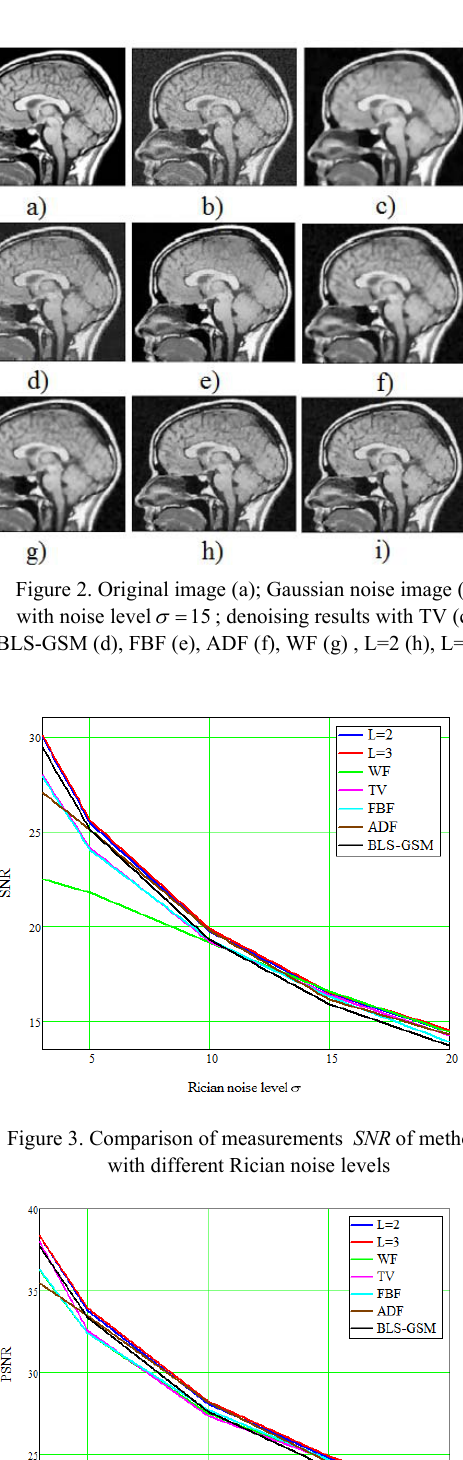
figure 3-8 with different Gaussian and Racian noise